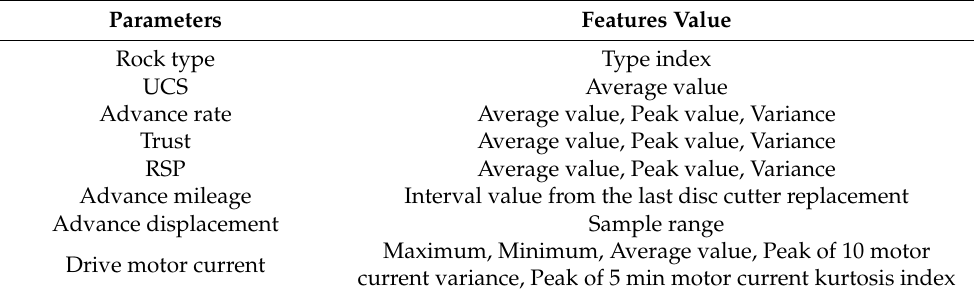
Table 3. Selected parameters and their augmented features.